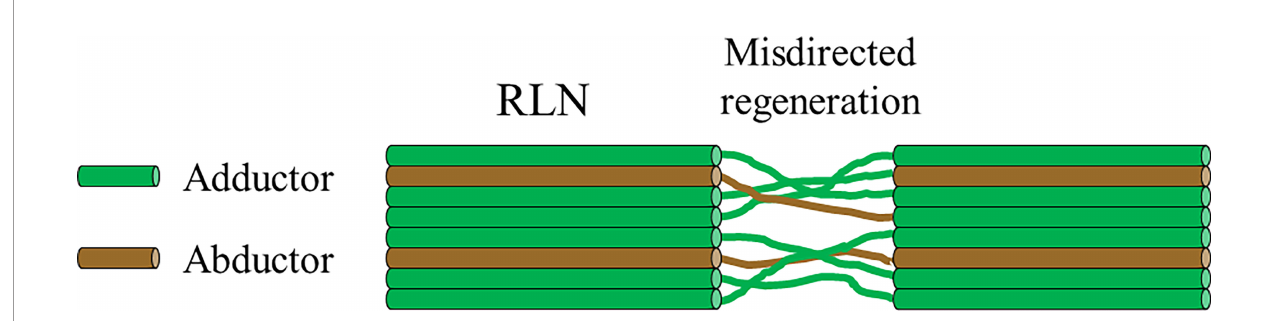
FIGURE 6 | Misdirected regeneration of the recurrent laryngeal nerve. The RLN contains adductor and abductor nerve fi bers without special segregation of these nerve fi bers within the RLN. Following the anastomosis, the nerve fi bers regenerate in a mixed fashion.